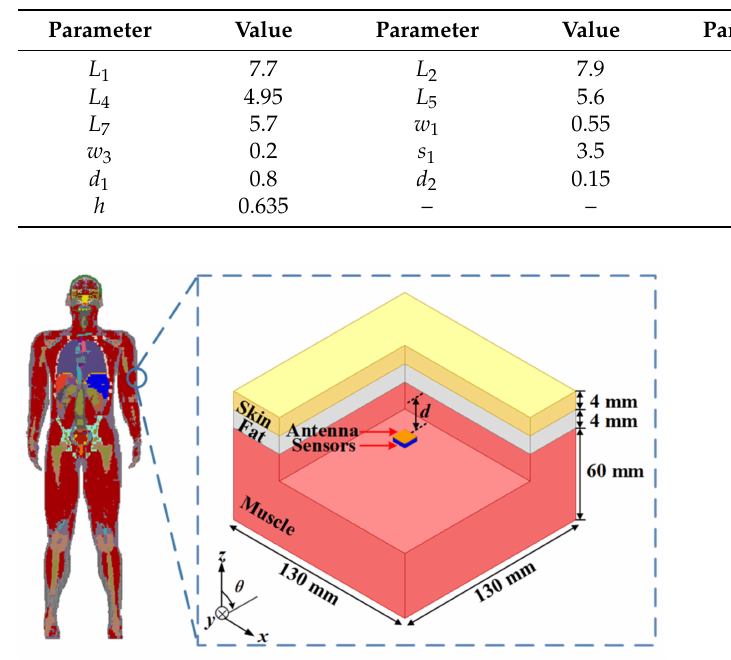
Figure 2. Simulation environment of the three-layer phantom